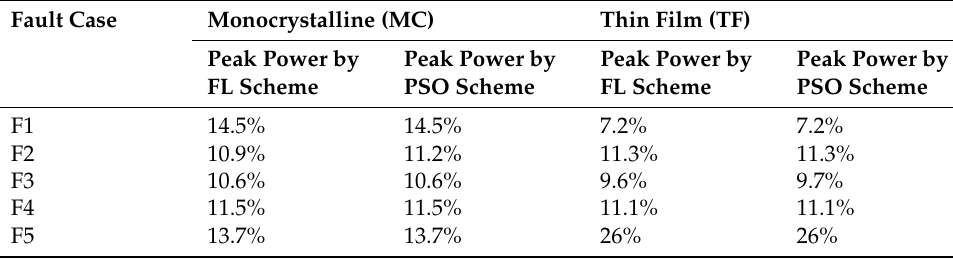
Table 6. Percentage increase in peak power from MC and TF PV arrays under various faults.